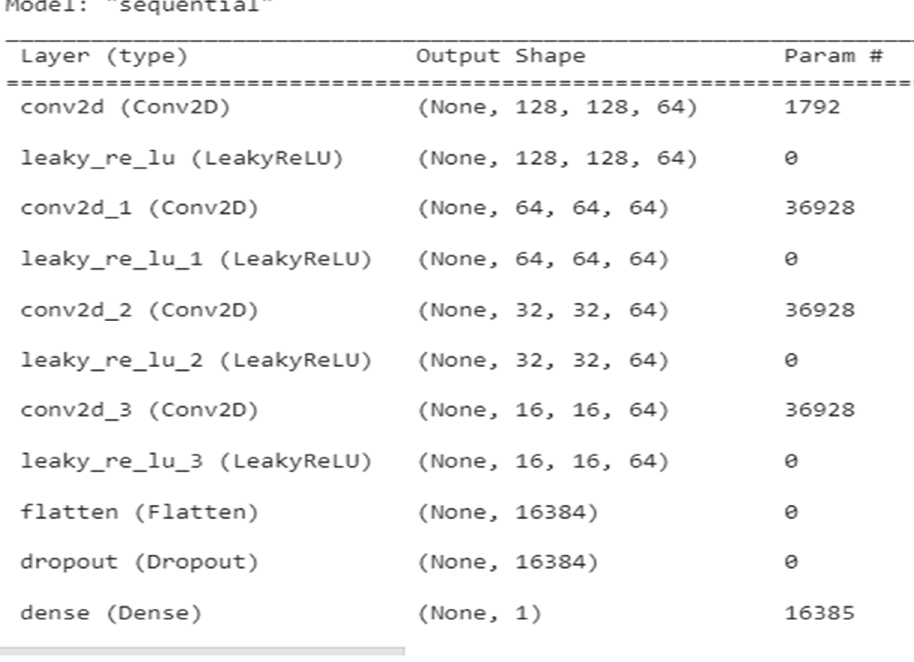
Figure 2. Discriminator summary for tumour segmentation.